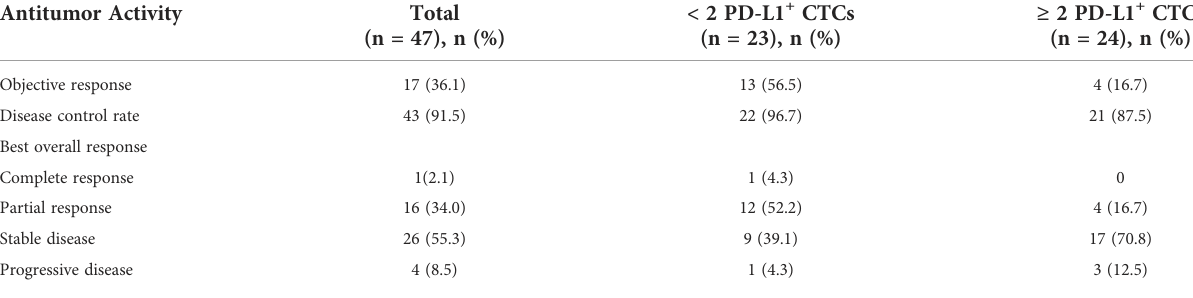
TABLE 2 Antitumor activity of patients with ≥ 2 or < 2 PD-L1 + CTCs assessed by mRECIST . Antitumor Activity